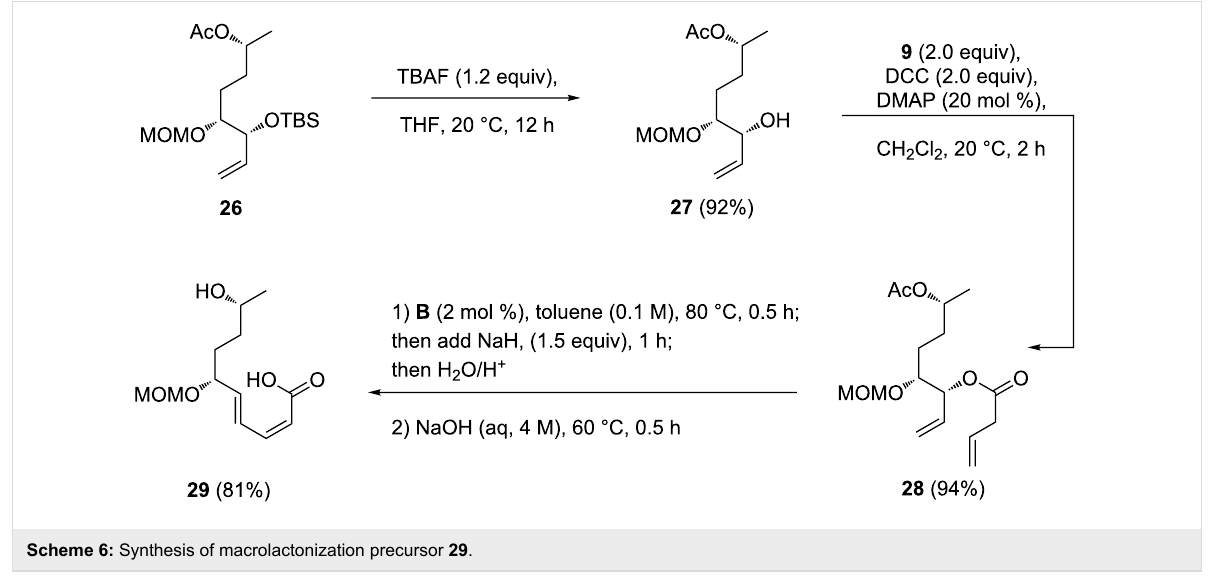
Scheme 6: Synthesis of macrolactonization precursor 29